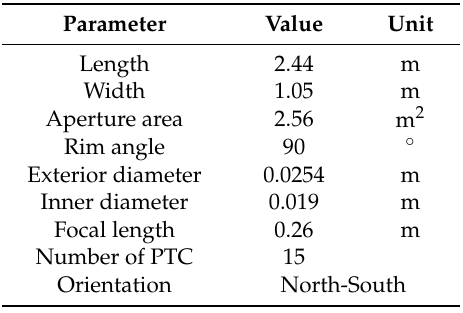
Table 1. Parameters of parabolic trough collector.